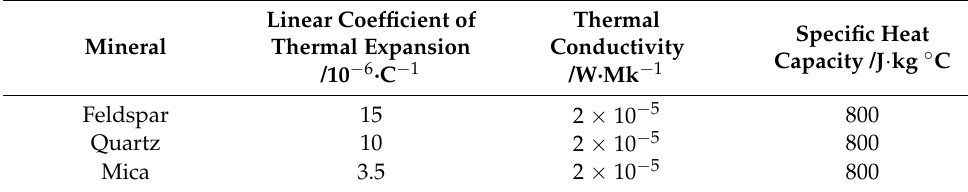
Table 4. Thermal microparameters of granite